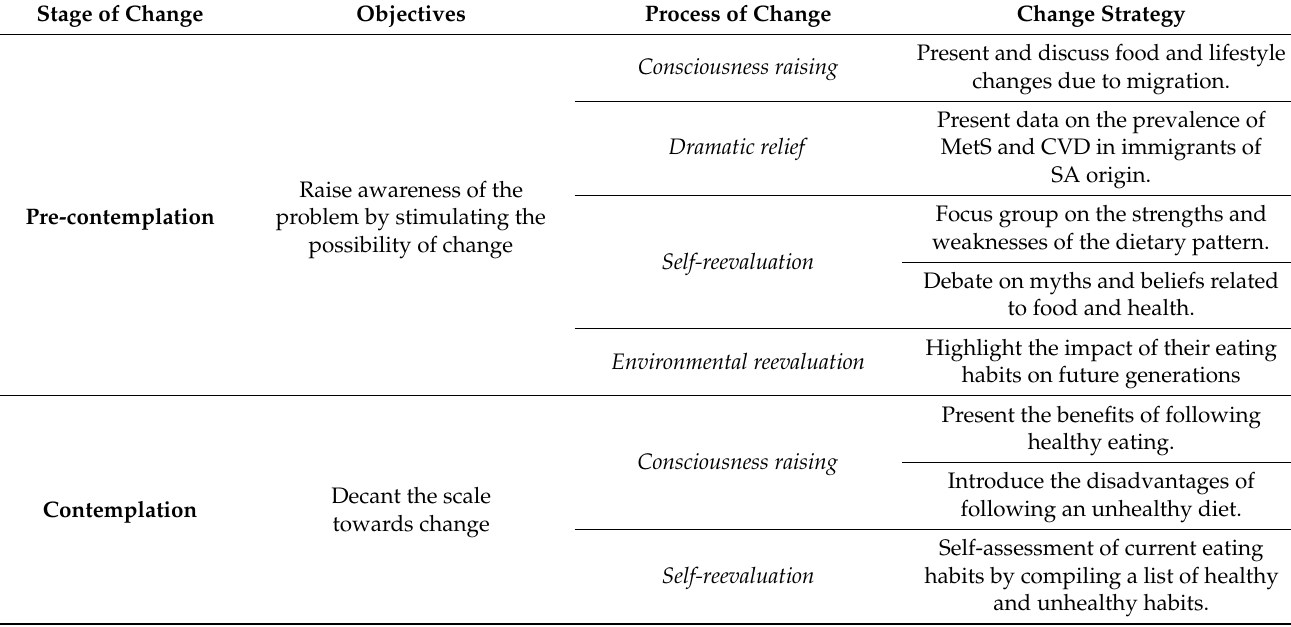
Table 2. Food education intervention based on the Transtheoretical